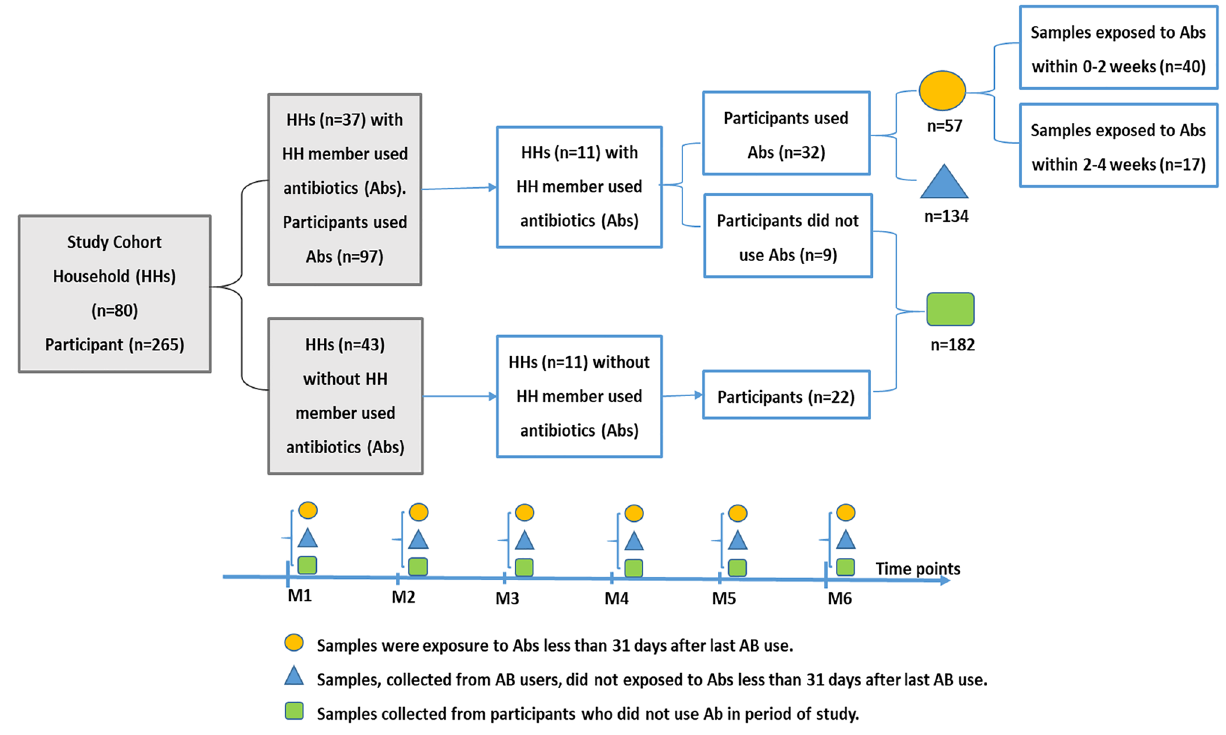
Figure 1. Study design and classification of samples into categories based on the number of days of exposure to antibiotics prior to sampling. The blue boxes indicate HHs, subjects and samples are part of the assessment. The light grey boxes indicate HHs of the study cohort and part of participants whose samples did not be included in the